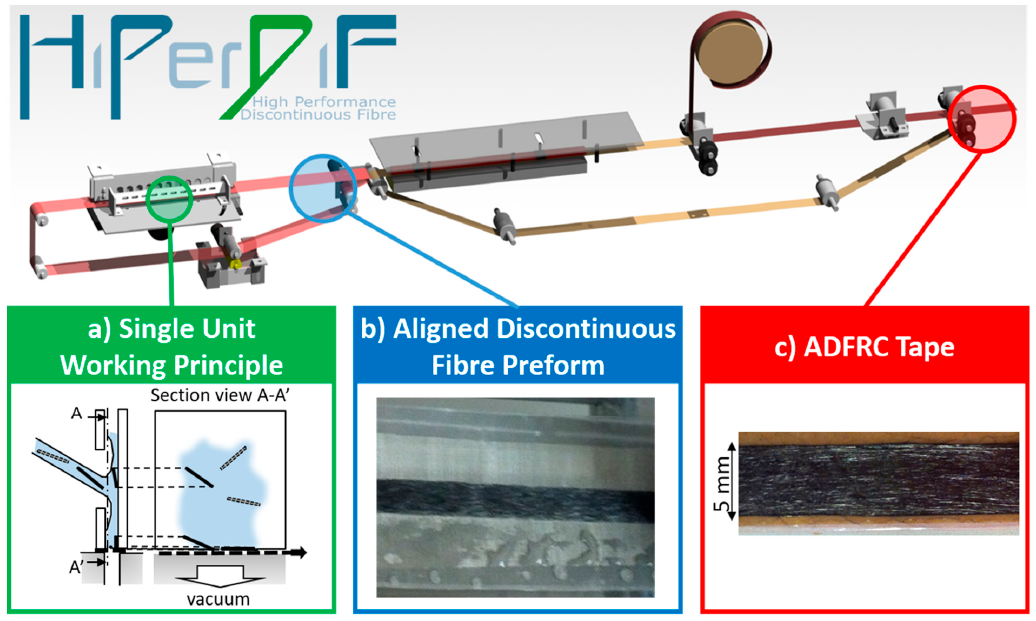
Figure 1. Schematic of the HiPerDiF alignment process.